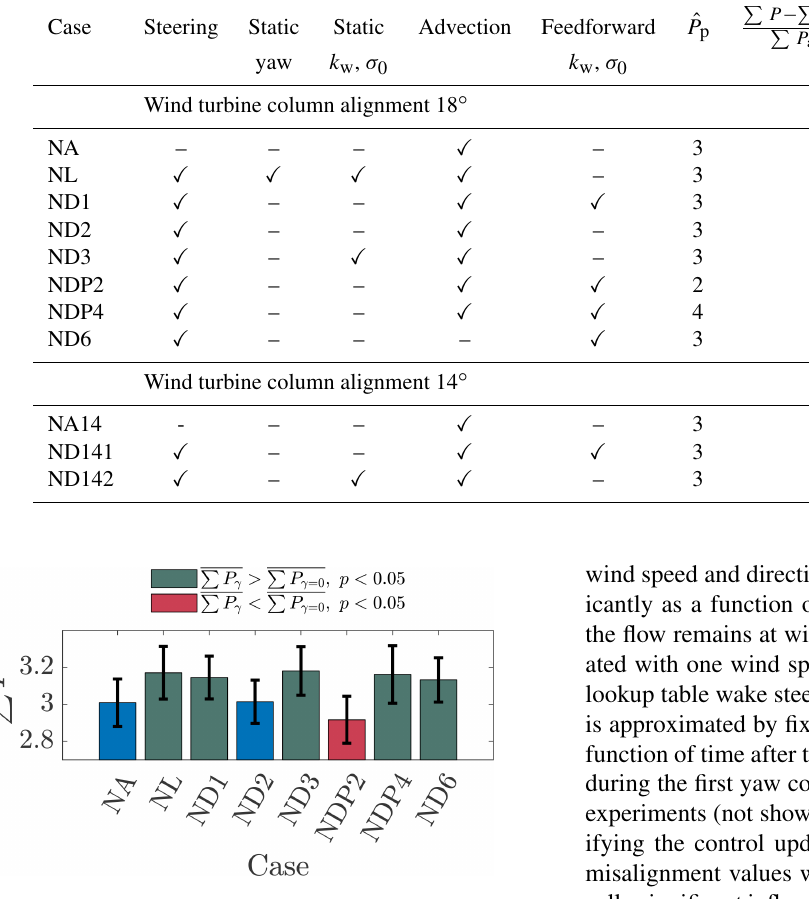
Figure 5. Time-averaged sum of the six-turbine-array power pro- duction for the conventionally neutral ABL LES cases described in Table 1. The error bars denote 1 standard deviation in the power pro- duction. The power production is normalized by the leading turbine P 1 in baseline control conditions. The statistical significance of the wake steering power production difference with respect to the base- line control Case NA is indicated by the colors. The statistical sig- nificance is characterized by a one-sided two-sample Kolmogorov– Smirnov test at a 5% significance level. Case NA is blue, and Case ND2 does not have a statistically significantly greater power pro- duction than Case NA. Green cases have statistically significantly ( p < 0 . 05) more power than Case NA. Red cases have statistically significantly ( p < 0 . 05) less power than Case